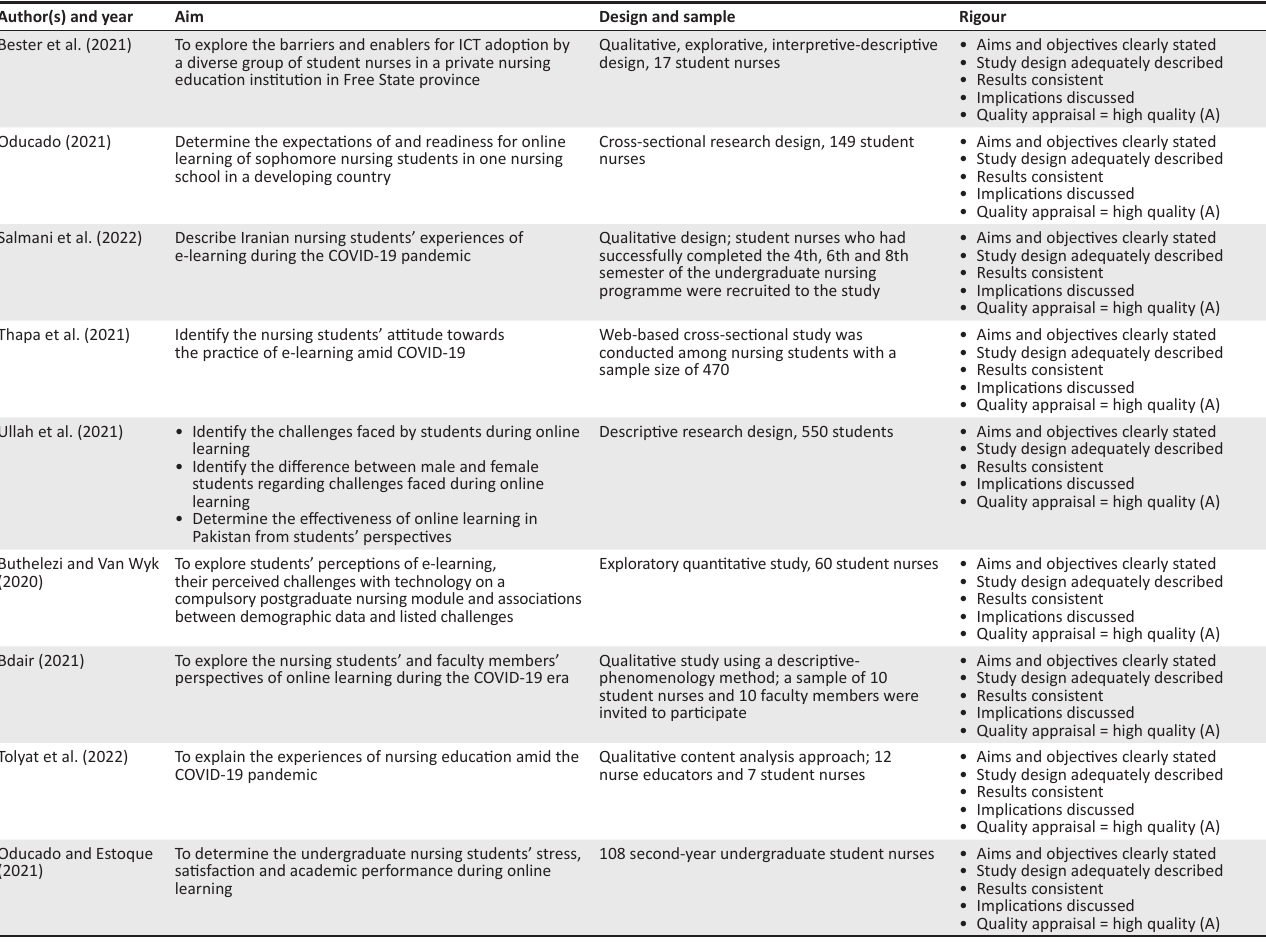
TABLE 2: Verify the availability of all the selected studies. Author(s) and